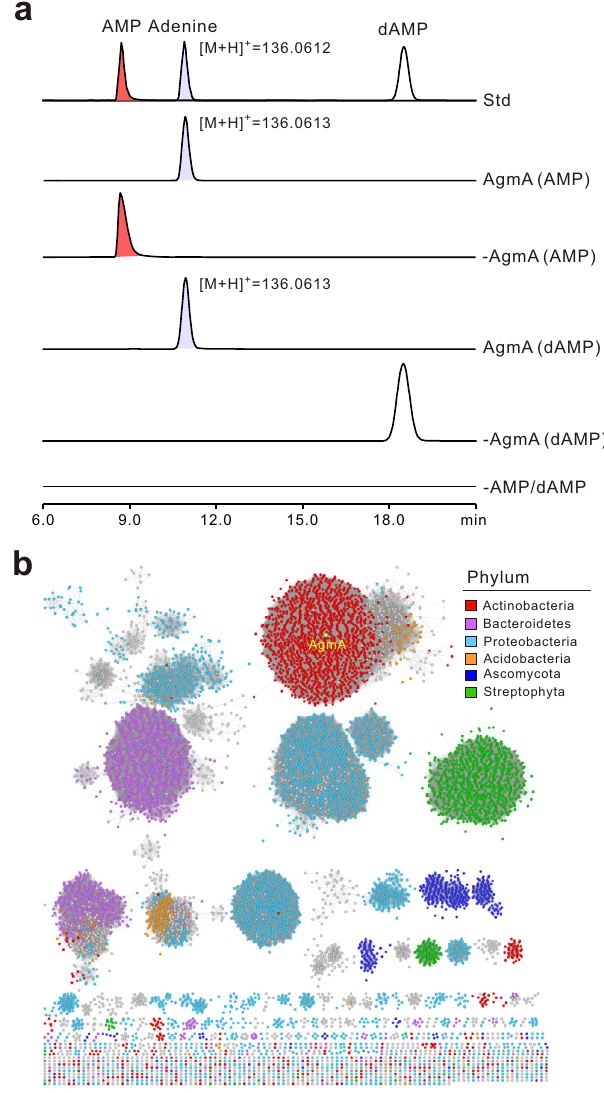
Fig. 3 Functional characterization of AgmA as AMP phosphoribohydrolase. a HPLC traces ( λ = 254 nm) of the AgmA reactions using AMP or dAMP as the substrate. Std, the authentic standards of AMP, dAMP, and adenine; AgmA(AMP), AgmA reaction with AMP as substrate; -AgmA(AMP), reaction using AMP as substrate but without AgmA added; AgmA(dAMP), AgmA reaction with dAMP as substrate; -AgmA(dAMP), reaction using dAMP as substrate but without AgmA added; -AMP/dAMP, AgmA reaction without AMP or dAMP added. b Sequence similarity network (SSN) of 9058 AgmA homologs generated by Cytoscape (v3.8.2). Each node in the network represents a protein sequence and the alignment score is 70. AgmA falls into the actinobacteria cluster and is highlighted by a yellow those of the reported SAH hydrolases with SAH as substrate 35 .